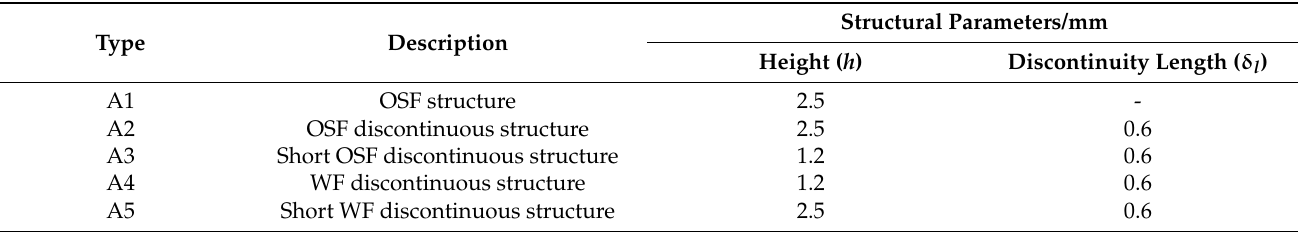
Table 2. Structural dimensions of internal channels.